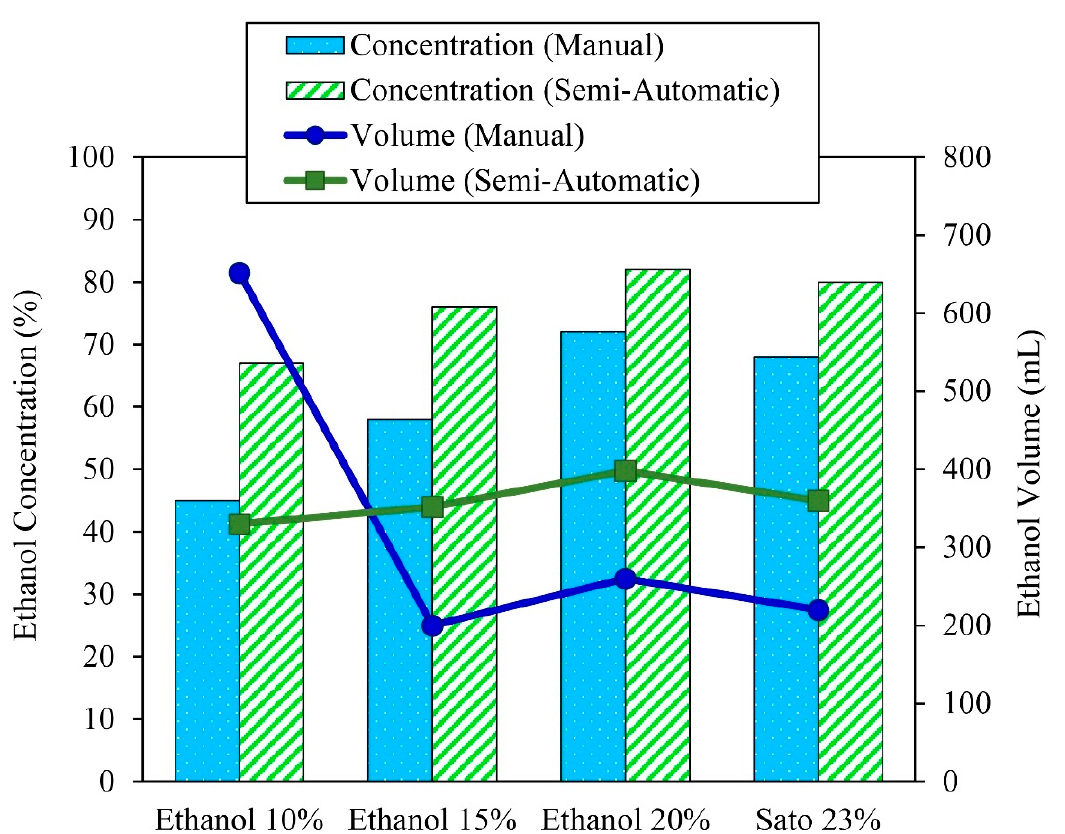
Figure 7. Comparison of the distilled ethanol volume and ethanol concentration of the different solution concentrations between semi-automatic controlled and manual controlled ethanol distilla- tion.